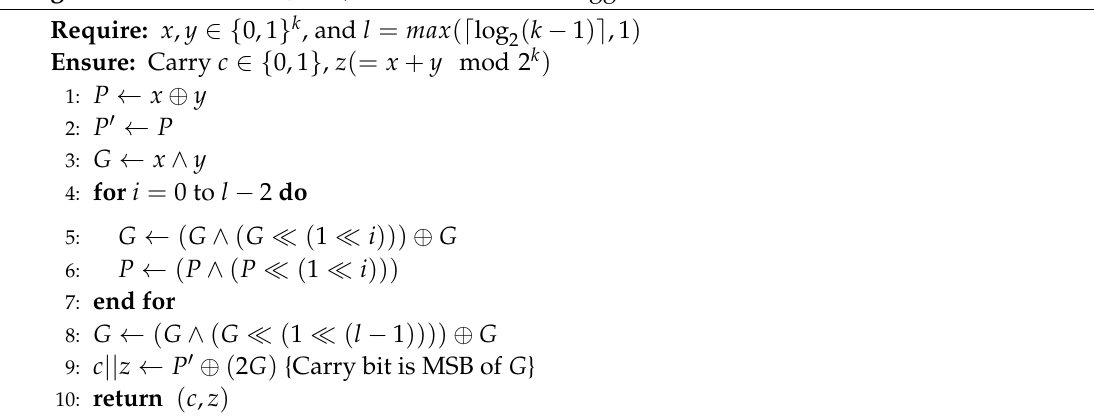
Figure A1. Concepts and examples of our, Coron’s, and Won’s Software-based Kogge–Stone Adder Algorithms. Algorithm A1: KSAdder Coron , Modified Coron’s Kogge–Stone